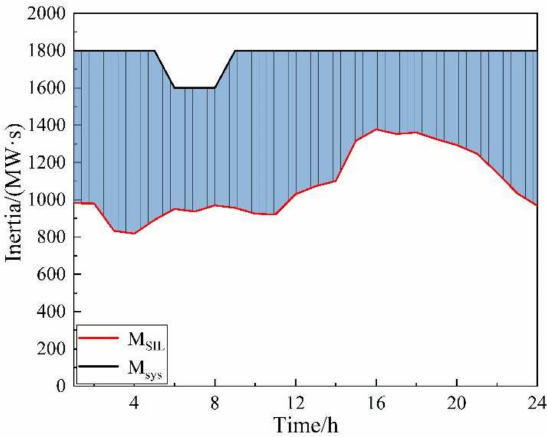
Figure 18. Typical daily inertia security region for scenario 3.